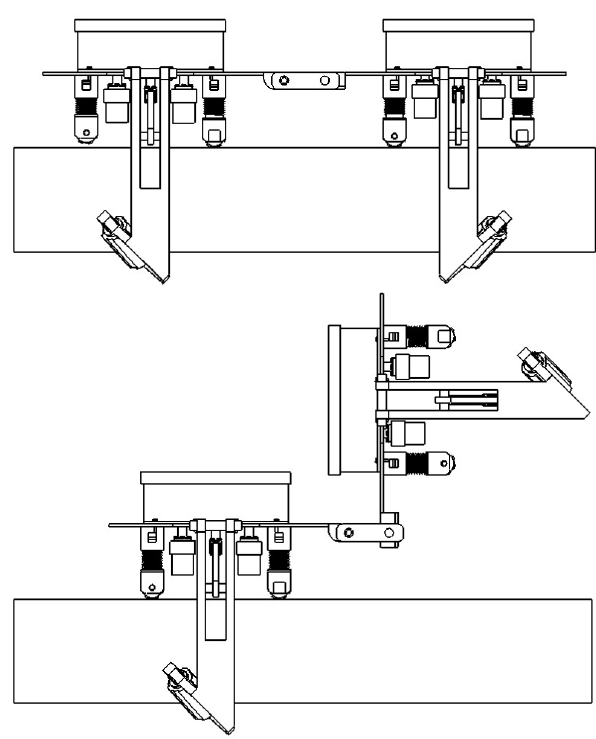
Figure 5. The robot under the full-load